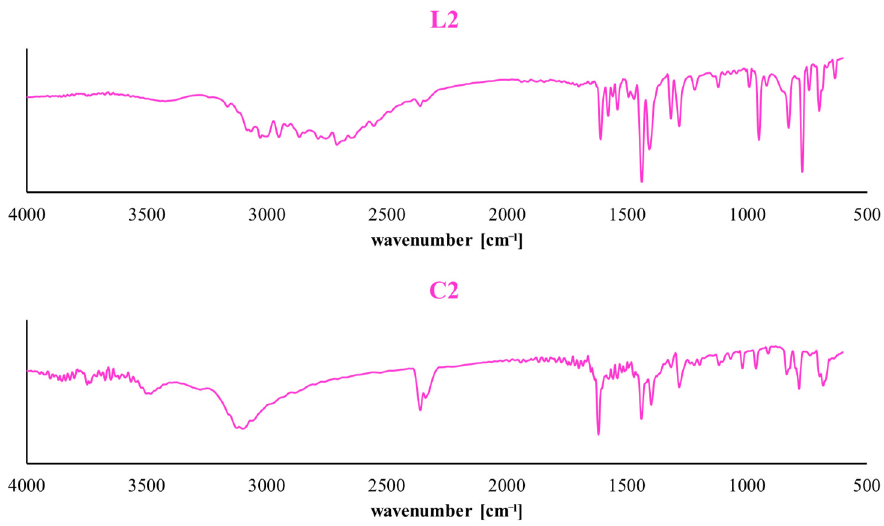
Figure 2. FTIR spectrum of free organic ligands L2 and complex C2 .